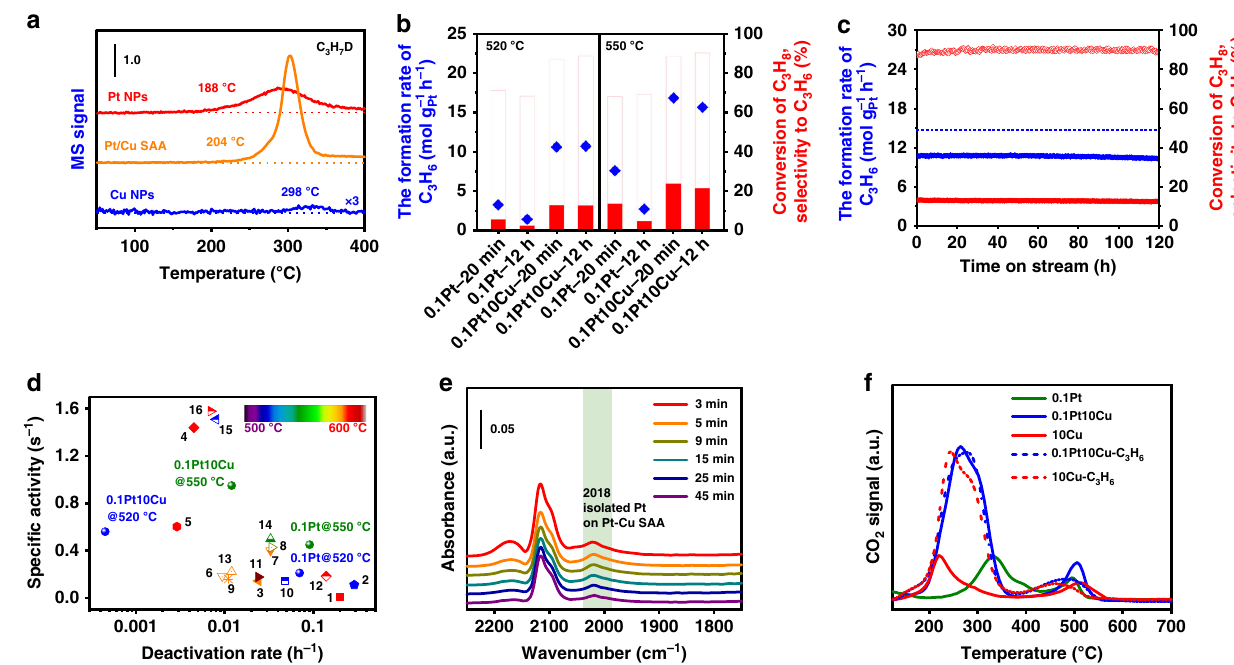
Fig. 5 Catalytic performances and characterizations of spent catalysts. a Signals of C 3 H 7 D during TPSR over 0.3Pt/Al 2 O 3 , 0.1Pt10Cu/Al 2 O 3 and 10Cu/ Al 2 O 3 for P – D scrambling. The mass ratio of 45/44 represents the level of C 3 H 7 D. Compared with Pt nanoparticles, a little higher temperature of C – H activation for Pt/Cu SAA suggests a slightly weaker intrinsic activity of dehydrogenation. b Catalytic performances at the initial and fi nal period at 520 °C and 550 °C during 12 h PDH, showing signi fi cantly improved performances of Pt/Cu SAA compared with Pt nanoparticles. c Long-term stability test for 0.1Pt10Cu/Al 2 O 3 at 520 °C for 120 h, demonstrating its excellent stability. The thermodynamic conversion calculated as mole g − 1 Pt h − 1 is presented (dash line). d Normalized activities of the formation rate of C 3 H 6 by speci fi c content of Pt for the catalysts described in this work and in the literature (1 –